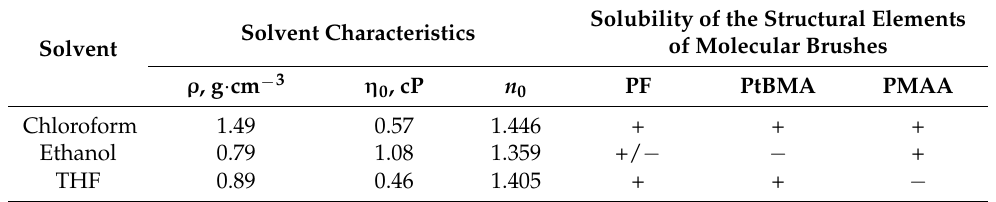
Table 1. Characteristics of solvents and solubility of the structural elements of molecular brushes. Solvent Solvent